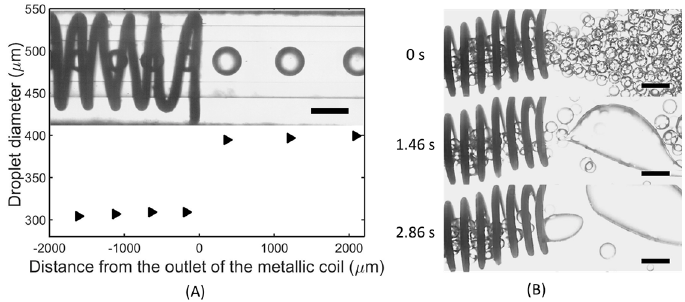
Figure 5. ( A ) The simulated electric field inside the coil compares with the one without coil; d p = 0.31 mm. ( B ) The simulated electric field inside coils with various pitch distances.